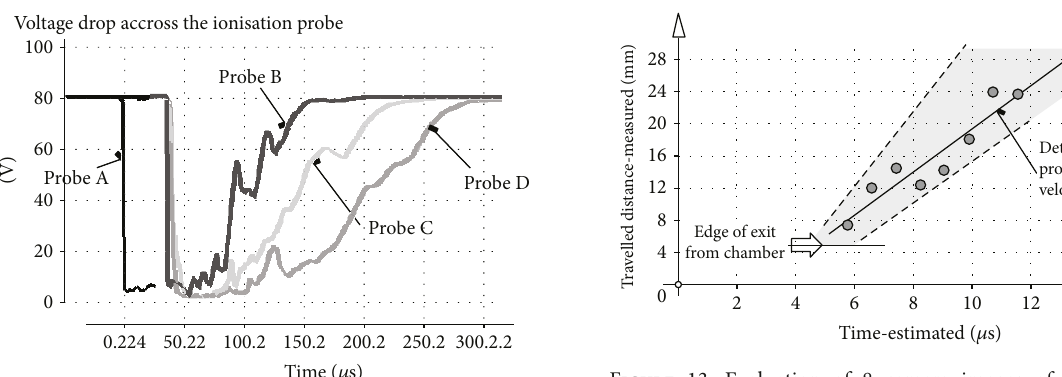
Figure 13: Evaluation of 8 camera images of the propagating wavefront has led to approximate detonation speed of the order of kilometres per second, demonstrating that the combustion was indeed of the detonation character. The grey area shows the estimated region of possible